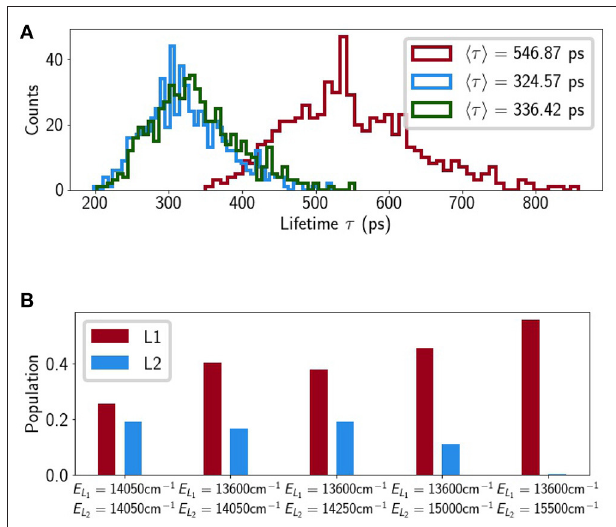
FIGURE 5 | (A) Lifetime histograms with E S set to 14,050 cm − 1 (red), 13,600 1 cm − 1 (blue) and 14,750 cm − 1 (green), and (B) average populations on L1 and L2 at τ , where E L denotes the S 00 1 energy assigned to Lut i i